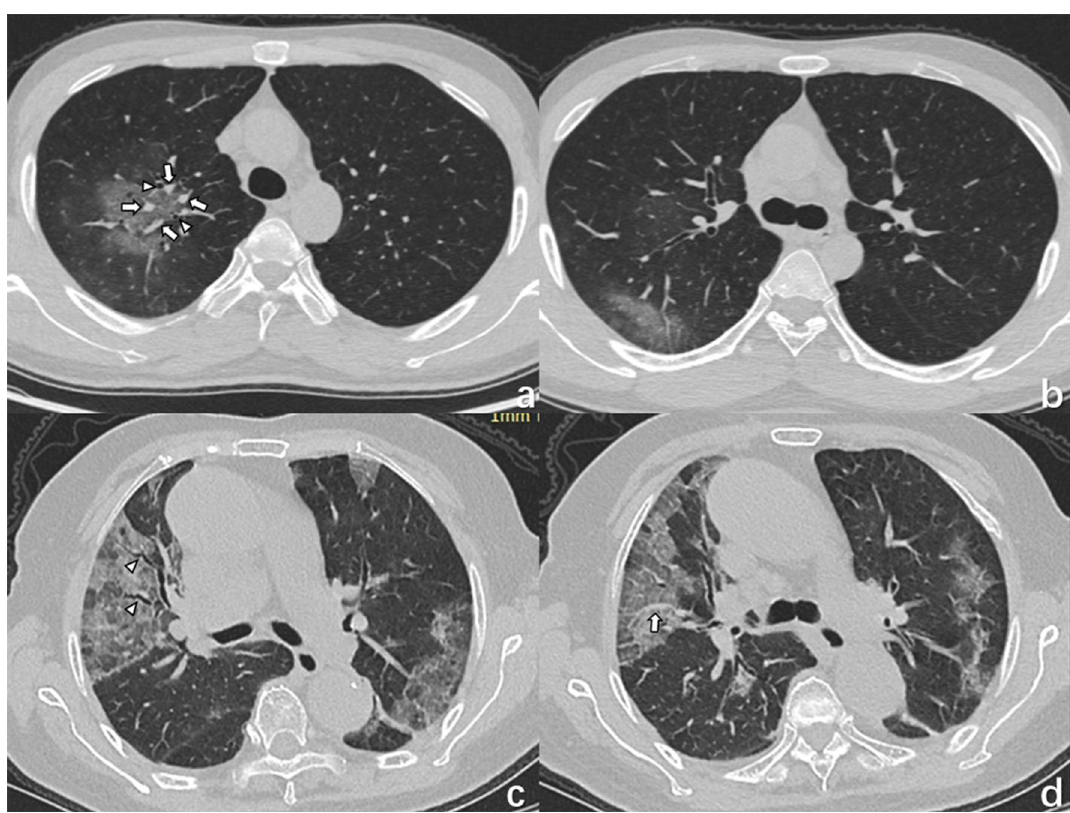
Figure 2. ( a , b ) A 33-year-old woman with COVID-19 infection, living in Wuhan, presented with fever, rhinocleisis, and dry cough. Axial ( a ) and coronal ( b ) CT images showing a subpleural mixed ground-glass opacity with multiple bronchiolectasis (triangles) and small vascular enlargement (arrow) in the right lower lobe. ( c , d ) A 47-year-old man with a COVID-19 infection, who traveled to Wuhan presented with fever. Axial ( c ) and coronal ( d ) CT images shows dominantly posterior- and inferior, multiple, GGOs with bronchiolectasis (triangles) and vascular enlargement